Question: Describe this figure in one sentence.
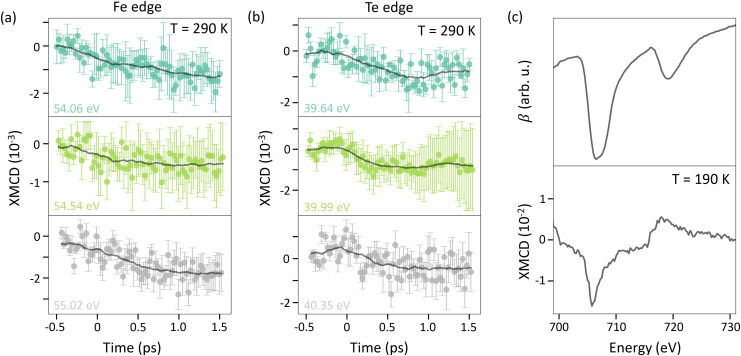
Answer: Time-resolved XMCD measurements at the (a) Fe M 2 , 3 and (b) Te N 4 , 5 edges at room temperature. The rolling mean of the XMCD is indicated by the black line as a guide to the eye. (c) Static absorption and XMCD at the Fe L 2 , 3 edges at 190 K , showing the ferromagnetic nature of the sample below Curie temperature.